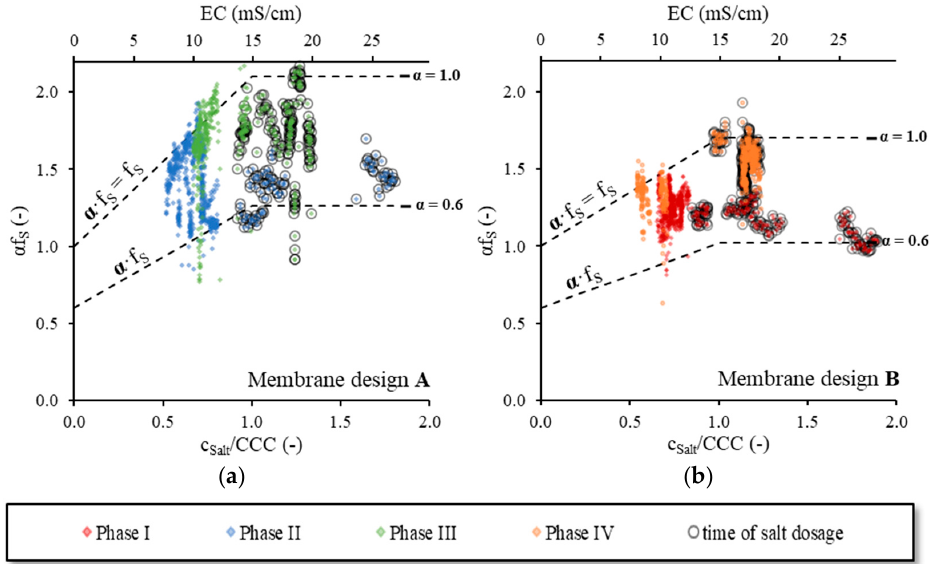
Figure 8. ( a ) α f S as a function of c Salt / CCC Salt for diffuser membrane design A and ( b ) diffuser mem ‐ brane design B. membrane design